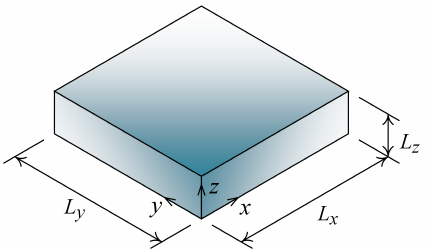
Figure 1. Schematic representation of plate, coordinate system and their dimensions. Table 2. Explicit definition of plate boundary conditions regarding to Examples 1, 2 and